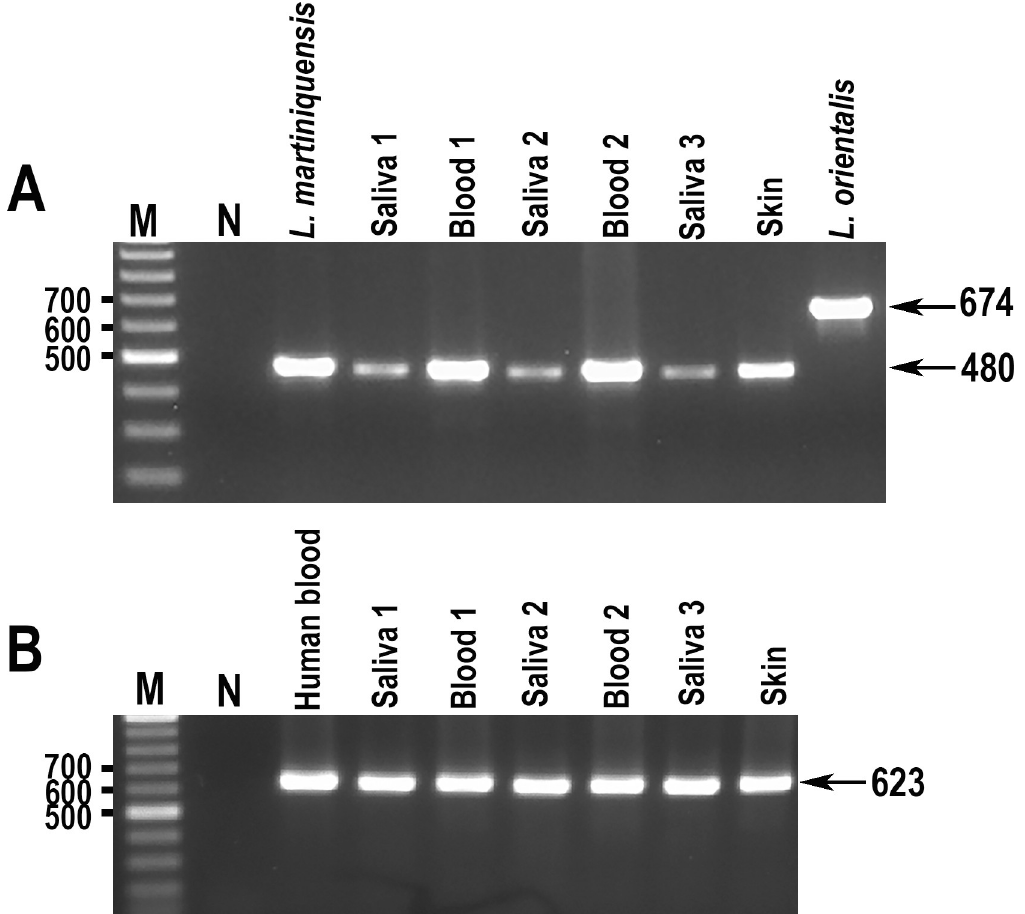
Fig 2. Agarose gel electrophoresis of HSP70-I -3 0 -UTR PCR products of DNA extracted from clinical samples. A. HSP70-I - 3 0 -UTR PCR products B. PCR products amplified using UNFOR403 and UNREV1025 primers. M = Molecular markers and N = Negative